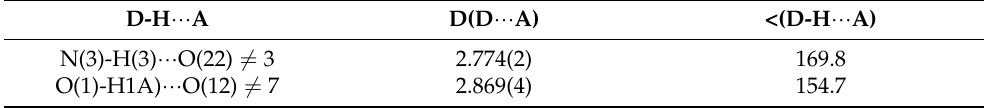
Figure 3. ( a ) Layers of the polymeric metal complex of 1 , pillared along the a axis of the crystal connected by (Him)N···O(carboxylate). Non-coordinated water and other intermolecular interactions omitted for clarity, to depict void channels where water is hosted. ( b ) Crystal structure fragment showing the π -stacking interaction between a pair of anti-parallel Him ligands, belonging to the external faces of two pillared layers of the polymeric metal complex of 1 . Table 4. Hydrogen bonds in the crystal of {[Cu 2 (µ 4 -EDTA)(Him) 2 ]·2H 2 O} n ( 1 ) [Å, °]. D = H-donor atom, A = H-acceptor atom.